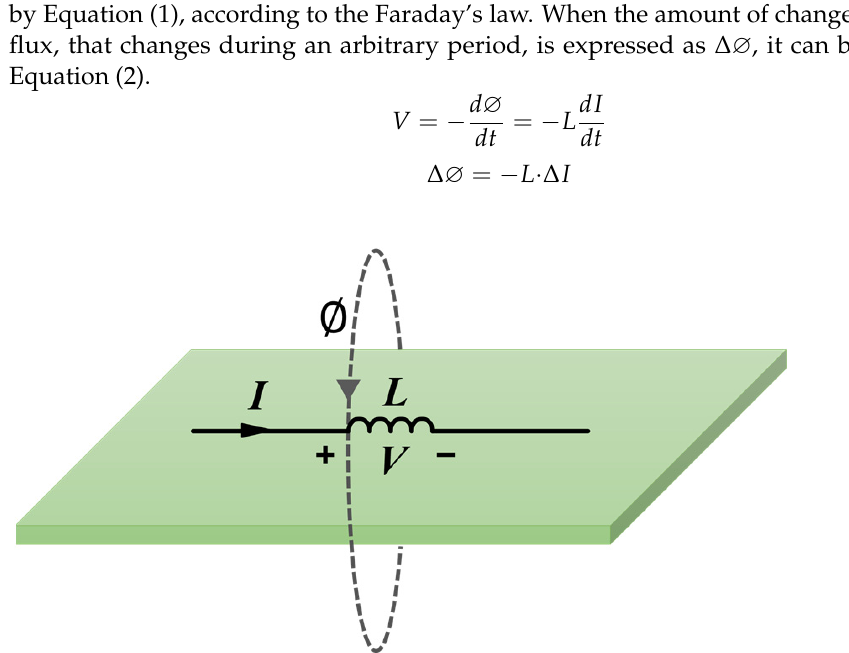
Figure 16. Lumped parameter-based parasitic inductance model. As shown in Equation (1), the magnitude of V induced by the parasitic inductance is proportional to the amount of instantaneous change in ∅ . Therefore, through the amount of ∆ ∅ in Equation (2), it is possible to know how much voltage overshoot and ringing occurs due to the corresponding parasitic inductance during the same switching period. With this relationship, we analyze the power loop in Figure 15, after performing the simulation of the DPT circuit. First, to analyze the power loop, the switching transient period needs to be defined. Figure 17 shows the simulation waveforms of turn-on and turn-off of the low switch. Here, I L is the load inductor current, v gs,l is the gate-source voltage of the low switch and i d,h and i d,l are the drain currents of the high and low switches, respectively. The switching transient period is defined as the time in which the switch drains current rises and reaches the peak. Next, analyze the amount of current change for each parasitic inductance during the switching transition. Figure 18 shows the current change for each parasitic inductance during the defined switching transient period. At the top layer, the current change is the largest between point 10 and point 11, as shown in Figure 18a,b. At the bottom layer, a relatively large current change is formed between the decoupling capacitor (points 5–17 and 23–35) and the high and low switches (points 18 and 36), as shown in Figure 18c,d. Through this process, it is possible to analyze the most important elements of parasitic inductance that cause overshoot and ringing during the switching transient